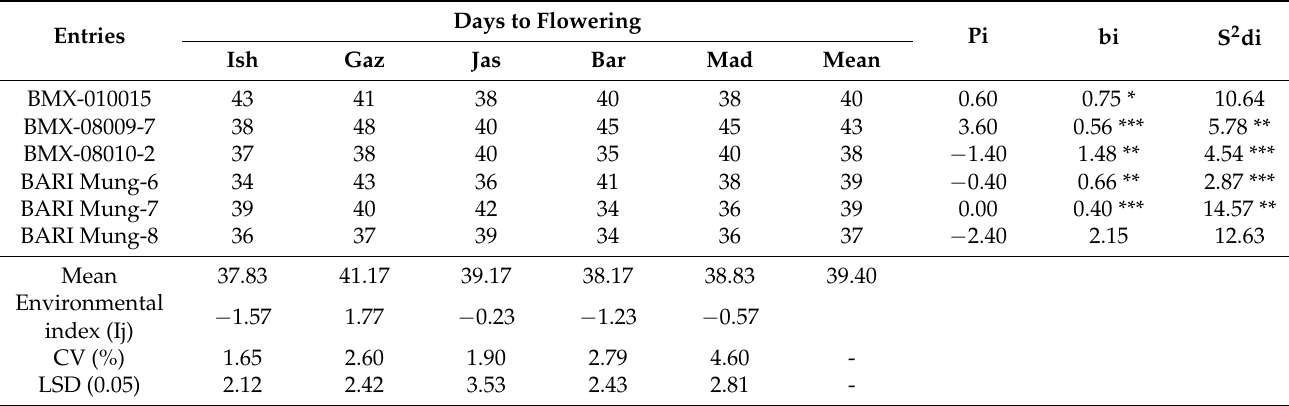
Table 4. Performance of mung bean genotypes for days to flowering at different environments during summer (Kharif-I) season, 2019. Entries